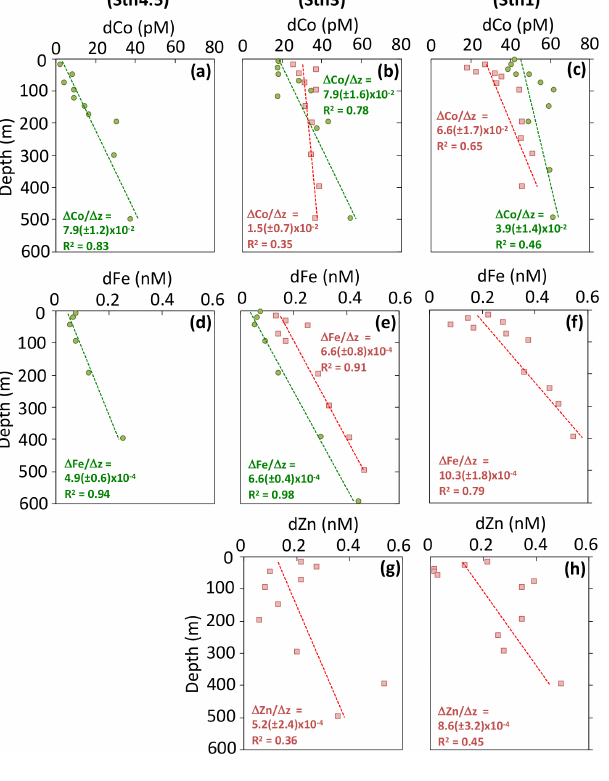
Figure 4. Depth profiles of dissolved trace elements (dCo, dFe, and dZn) in the upper ocean ( < 600m). Red squares show data from cruise JC068, and green circles show data from cruise D357. The dashed lines show linear regression trends, and the vertical gradient ( (cid:49) TE /(cid:49)z ) errors are ±